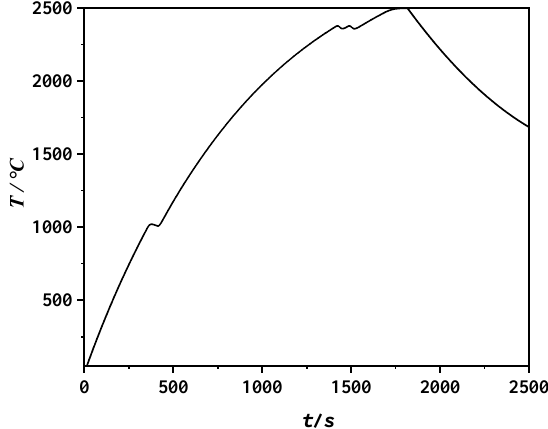
Figure 19. Temperature change of 2500 °C high-temperature impact test.